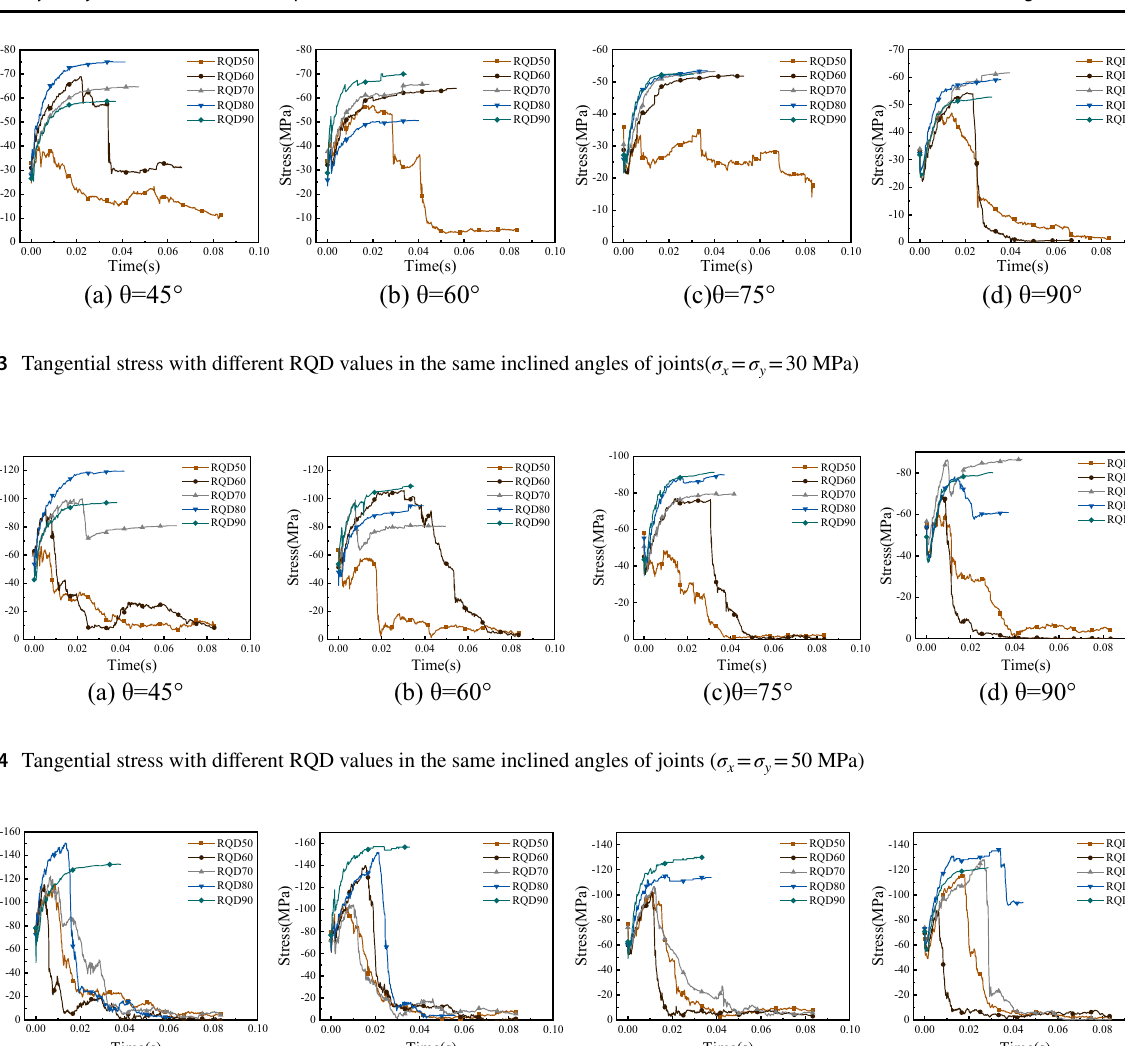
Fig. 15 Tangential stress with different RQD values in the same inclined angles of joints ( σ